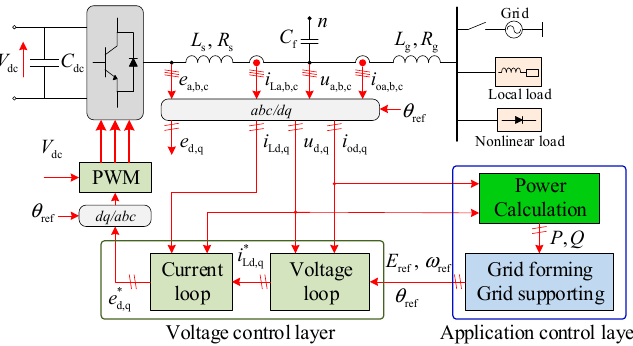
Figure 1. Topology and control structure of the three-phase voltage-controlled MG inverter. Fast and stable voltage control is the guarantee of reliable operation of the inverter.